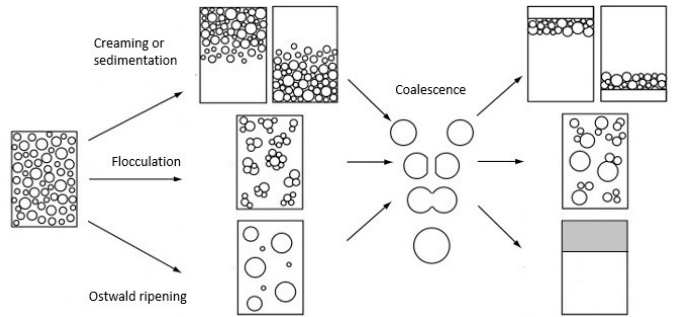
Figure 1. Breakdown mechanisms of an emulsion. Note that di ff erent processes may occur simultaneously. Adapted with permission from [13]. Copyright John Wiley and